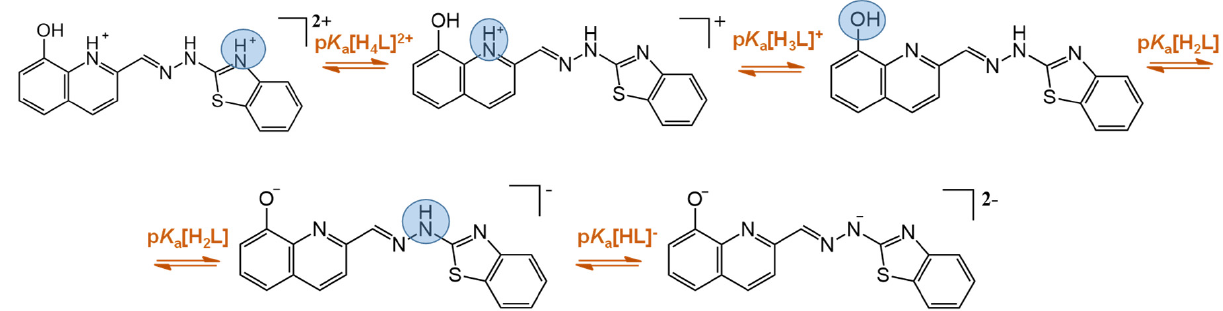
Figure 6. The suggested deprotonation steps of the ligand H 2 L. Table 4. Proton dissociation constants (p K a ) of the investigated compounds in 60% ( v / v ) DMSO/H 2 O mixture, in addition to the values predicted by Marvin software [55]. [ I = 0.10 M (KCl)]. Ligand (Predicted) Ligand 2-Hydrazinobenzothiazole p K a1 2.04 - - p K a2 2.90 1.99 ± 0.03 3.35 ± 0.03 p K a3 9.17 9.09 ± 0.04 10.35 ± 0.03 p K a4 10.09 12.99 ± 0.04 12.86 ± 0.03